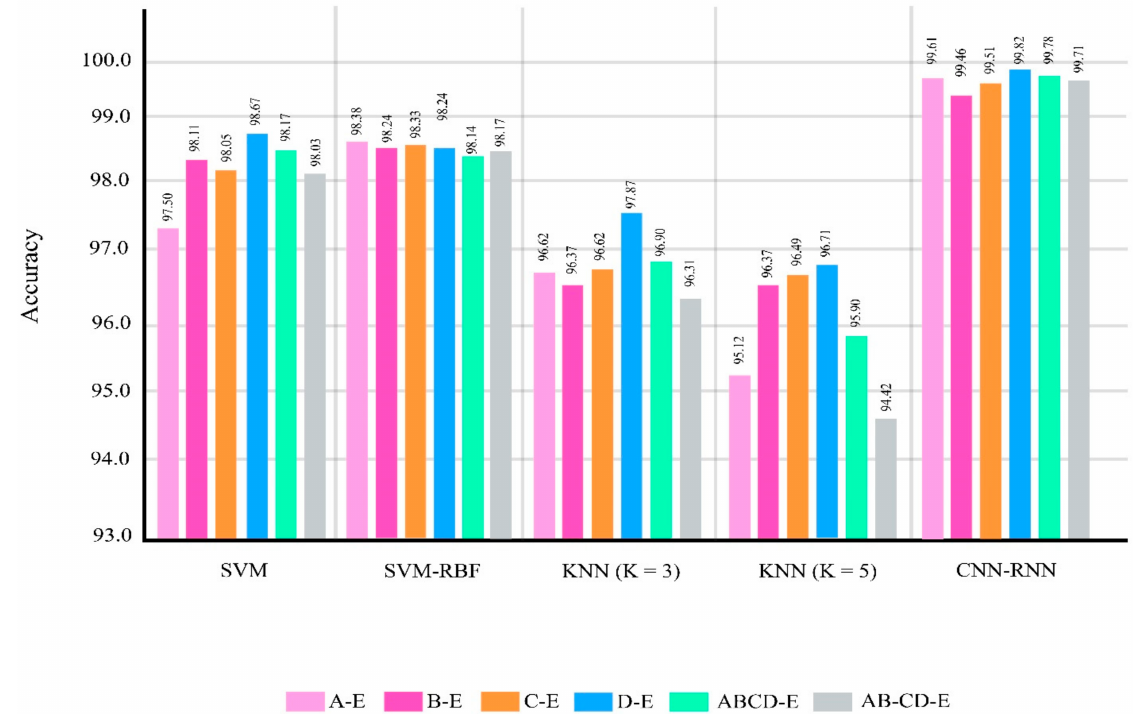
Figure 7. Results for different methods in different classification problems of the Bonn